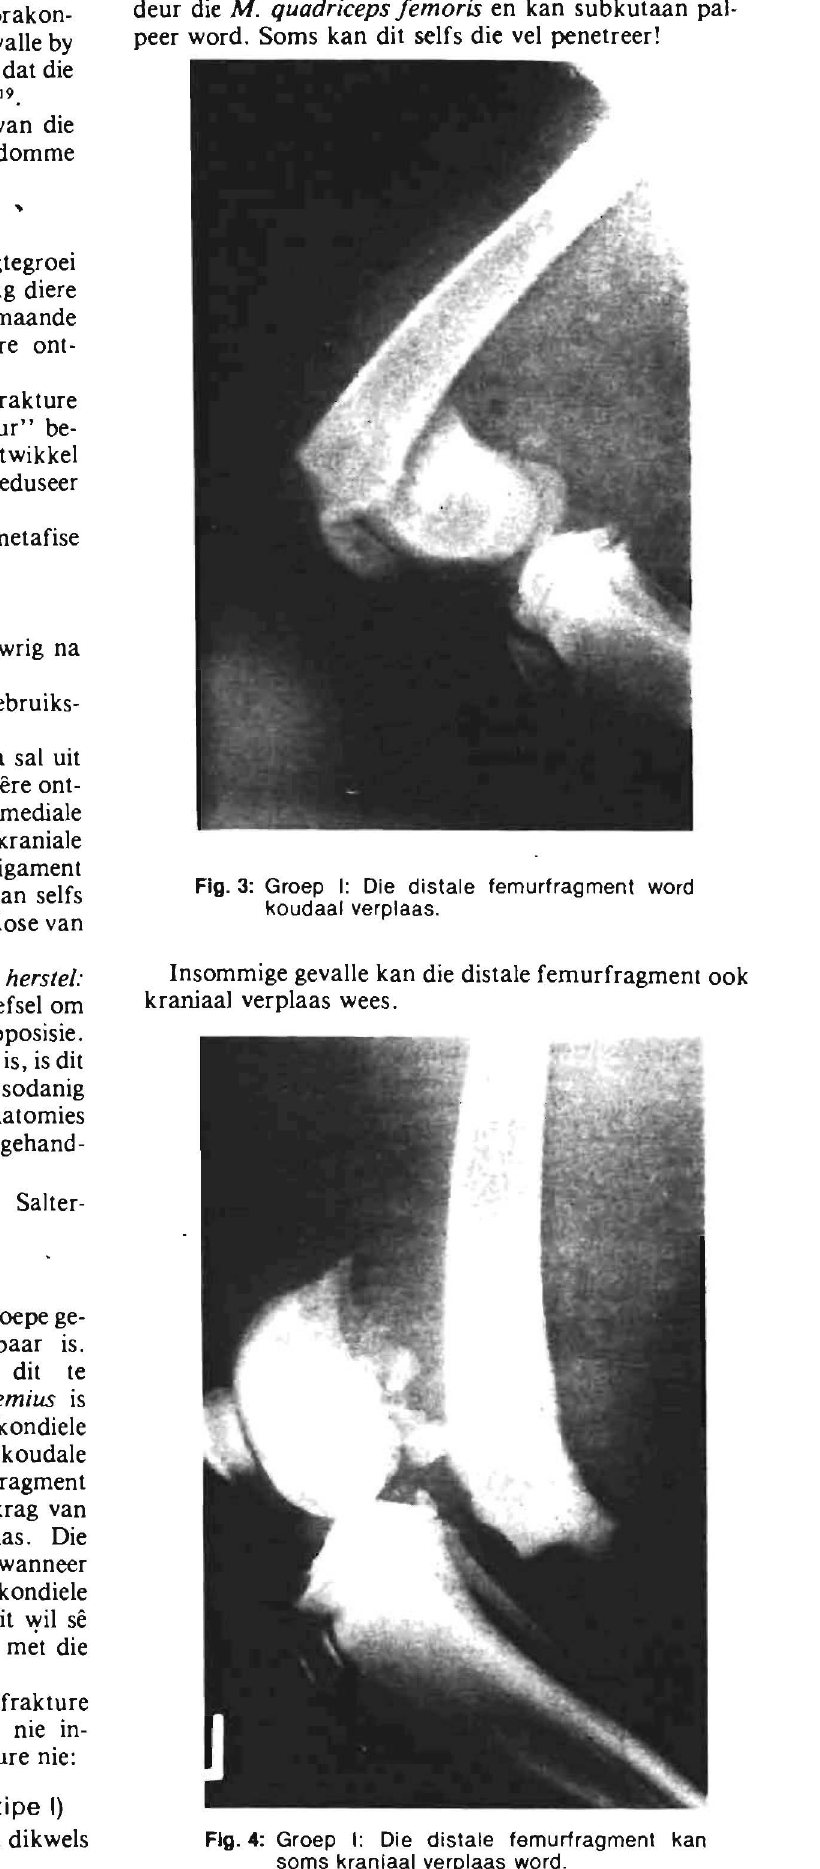
Fig. 4: Groep I: Die distale femurfragment kan soms kranlaal verplaas